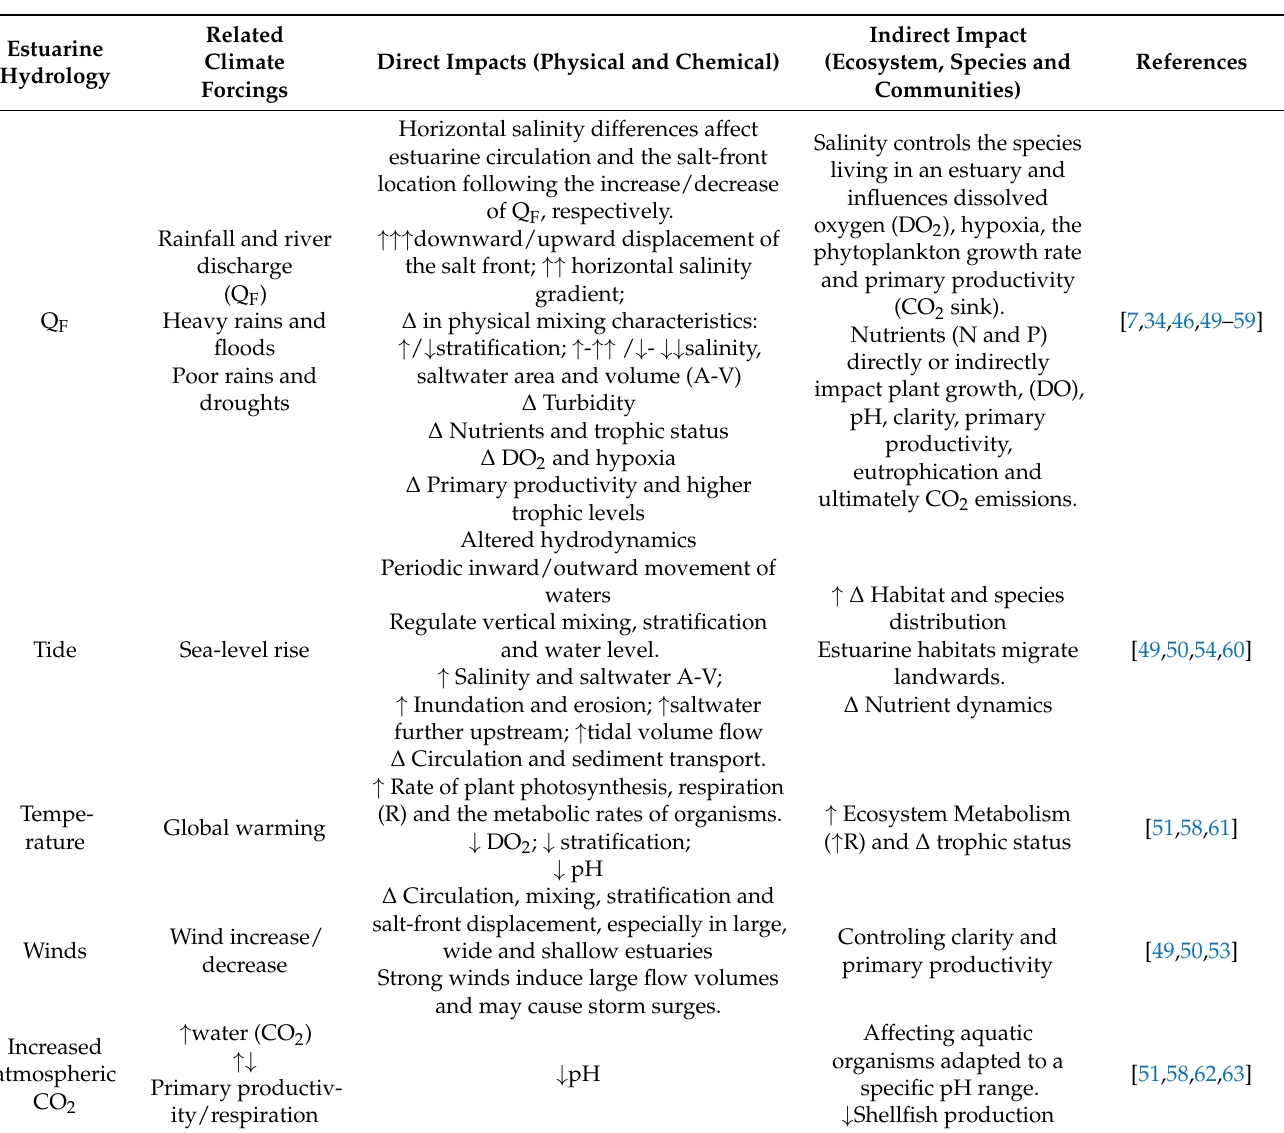
Table 2. Summary of estuarine hydrological processes, including effects and sensitivity of/to climate variability and change, current and near-future (2021–2040) threats from climate change and variabil- ity to estuaries, direct impacts (physical and chemical) and indirect impacts (ecosystem, species and communities). The magnitudes of impact (expert judgment based on the references) were